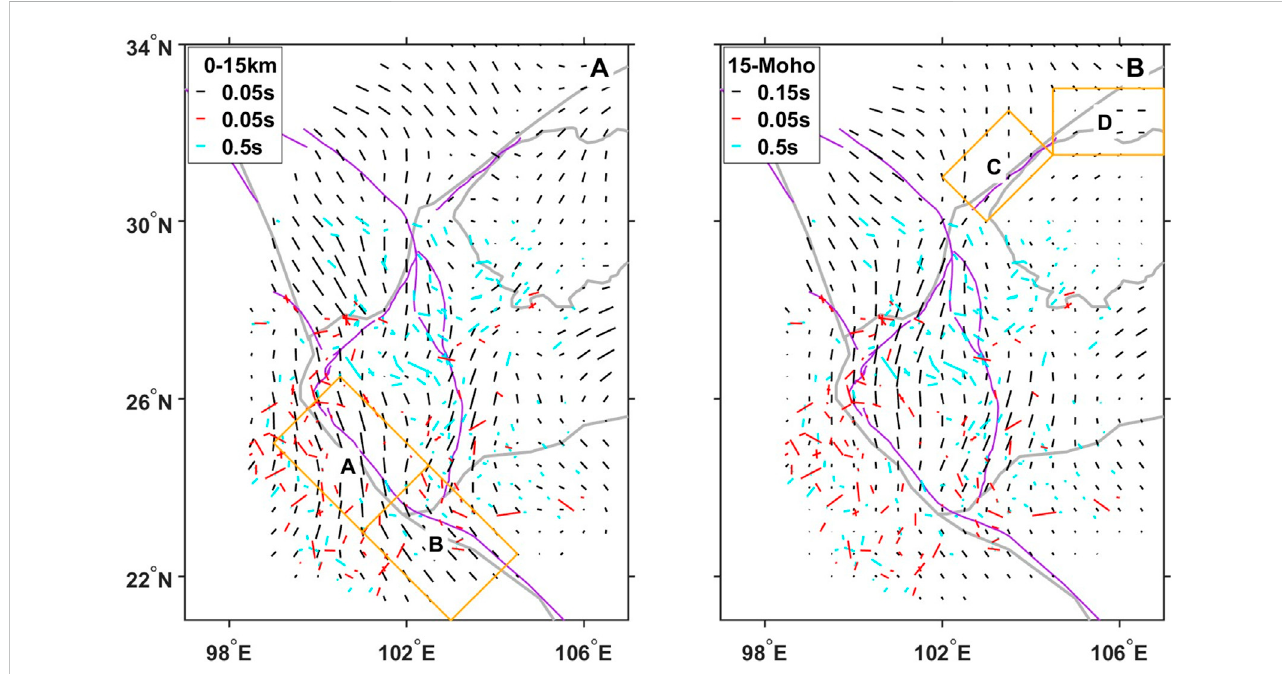
FIGURE 7 The comparison between the predicted shear wave splitting parameters (black bars) from our velocity model and the observed shear wave splitting parametersfromlocalevents (redbars)andPmsphasedata(light bluebars)atuppercrust (A) andmid-lower crust (B) .Thepurpleandgraylinesrepresentthe main fault and block boundary, respectively. The Moho depth is from He et al.